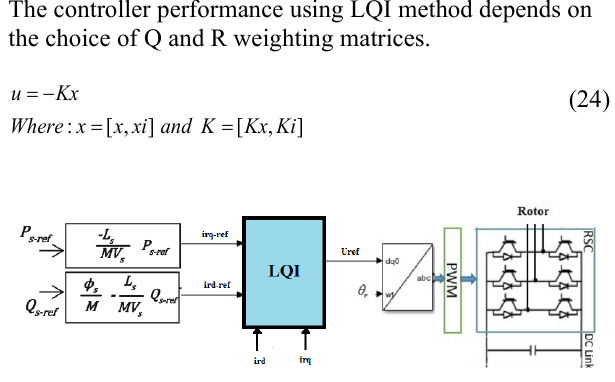
Figure 3. Block Diagram of the proposed LQI control design